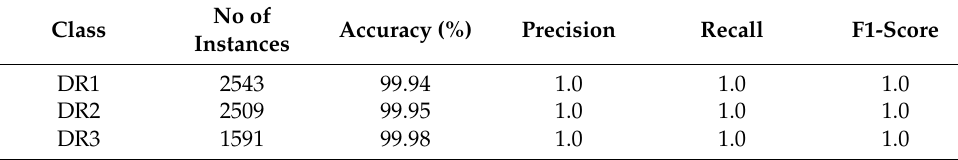
Figure 6. ROC curve ( left ) and fusion scatter plot ( right ) . Table 9. Results obtained using feature fusion approaches on different target